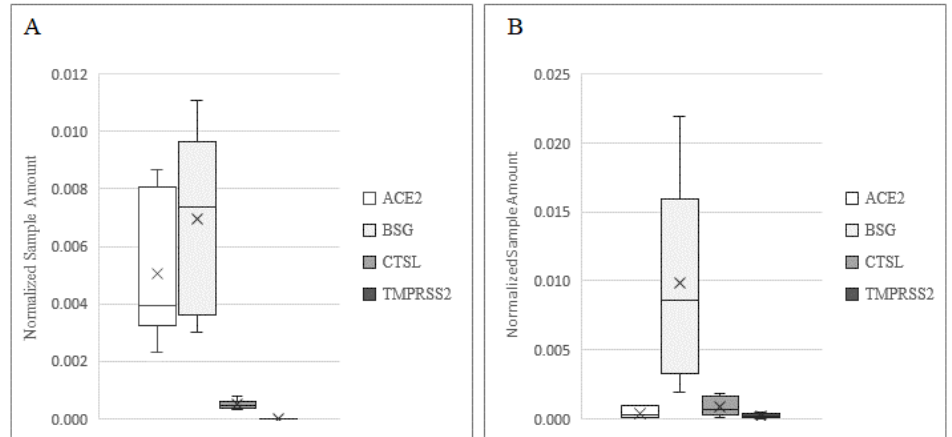
Figure 1. Expression of ACE2 , BSG , CTSL, and TMPRSS2 in human testis ( A ) and in ejaculated sperm. ( B ) Data are plotted as box–whisker plots, where boxes show the interquartile range with median and mean values, and whiskers represent min and max confidence intervals. Data were derived from 20 testicular biopsies and 10 sperm samples.